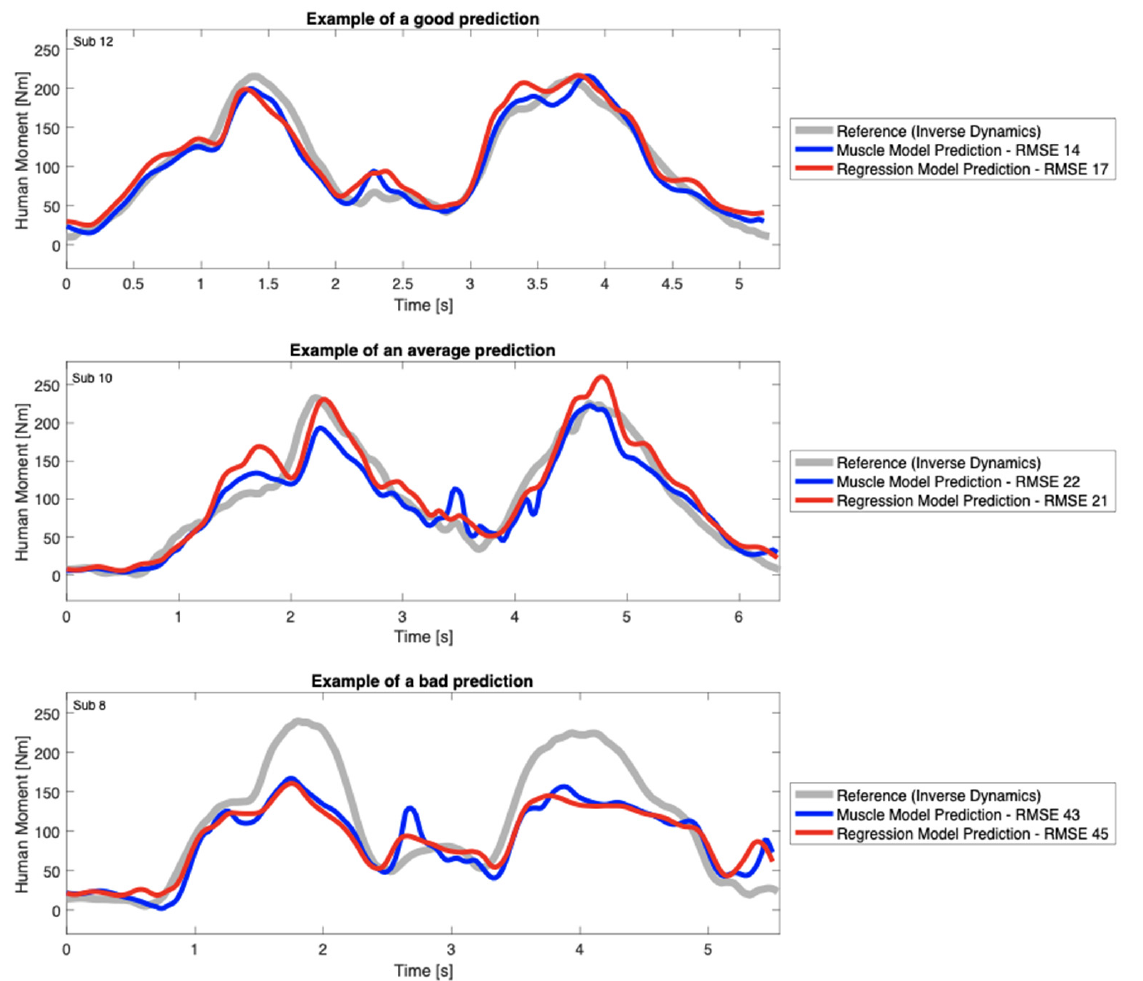
Figure 5. Examples of lumbar spine moment prediction during symmetric box lifting task. The reference values were determined by inverse dynamics, and the predictions were made by EMG- Mod and RegMod. The predictive accuracy for EMGMod and RegMod varied for different subjects, trials, and calibration sets. These examples were selected to illustrate the inverse relationship be- tween the predictive quality and the RMSE of the models.